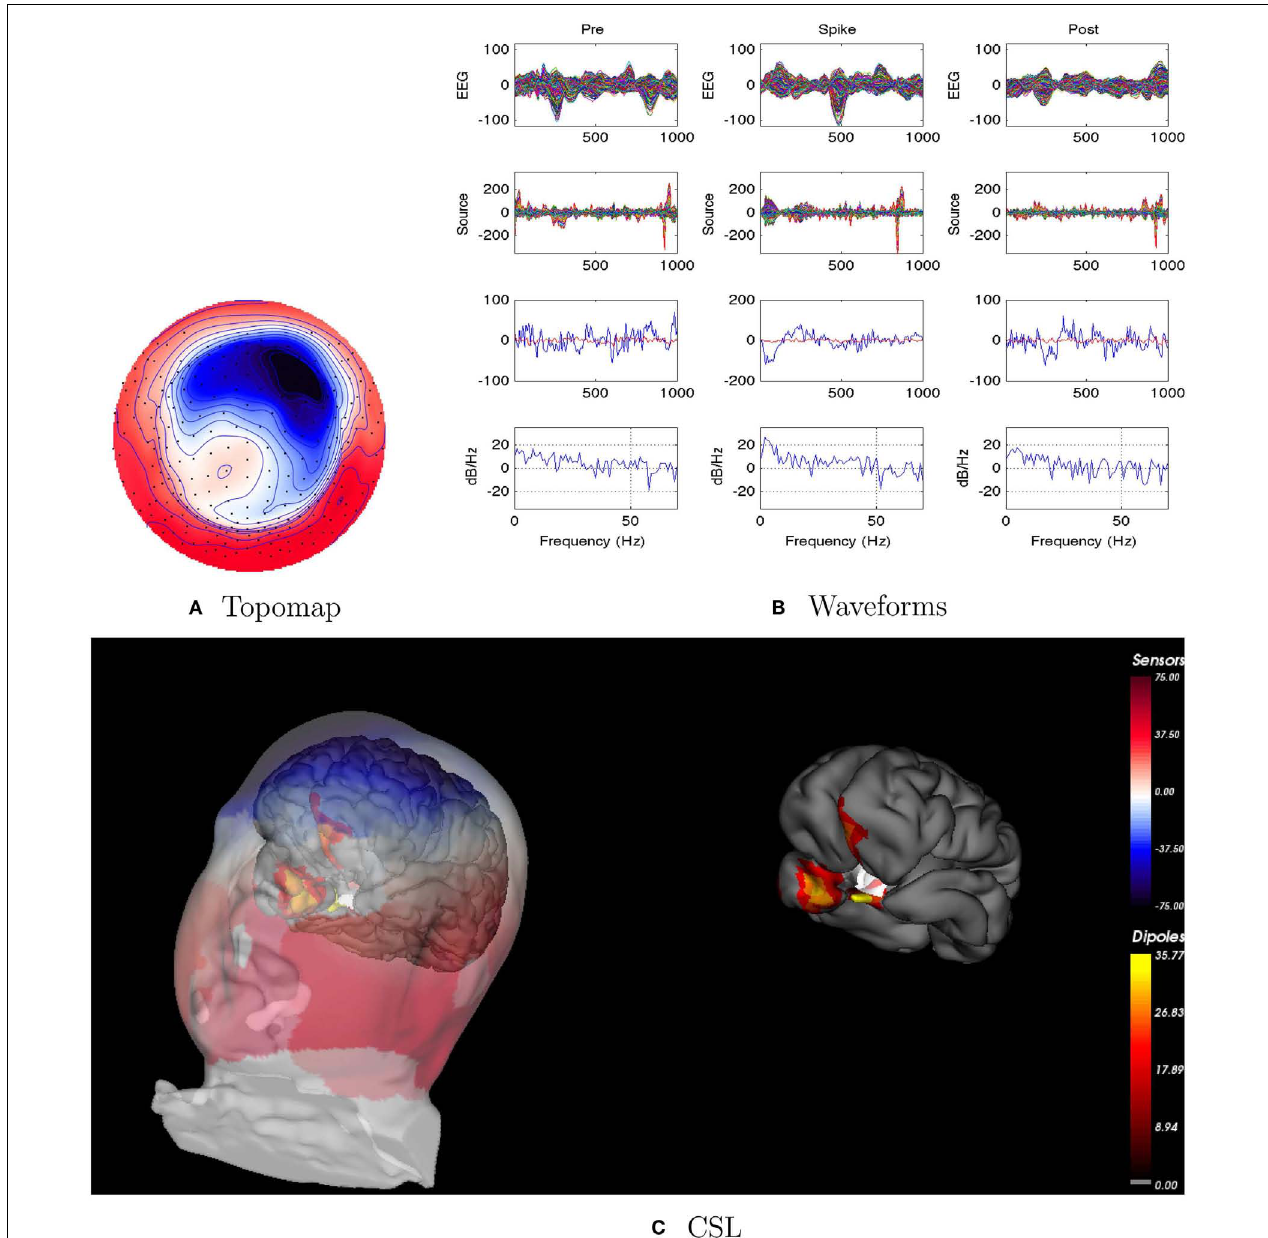
source waveforms (third row) shown in forth row. Note that the dipole location of the blue trace is in the right temporal lobe. In (B) , each column represents 1s of data from a 3-s segment. Middle column represent data centered on the spike peak. (C) Electrical source localization with the patient’s individual electrical head model. Left: scalp potential reconstructed from the source estimate (at 50% of spike peak). Right: partially inflated brain illustrating the dominant source associated with the data illustrated in left figure [location of dipole described by blue trace in (B) , third row]. Data was thresholded to only show top 5% activity.